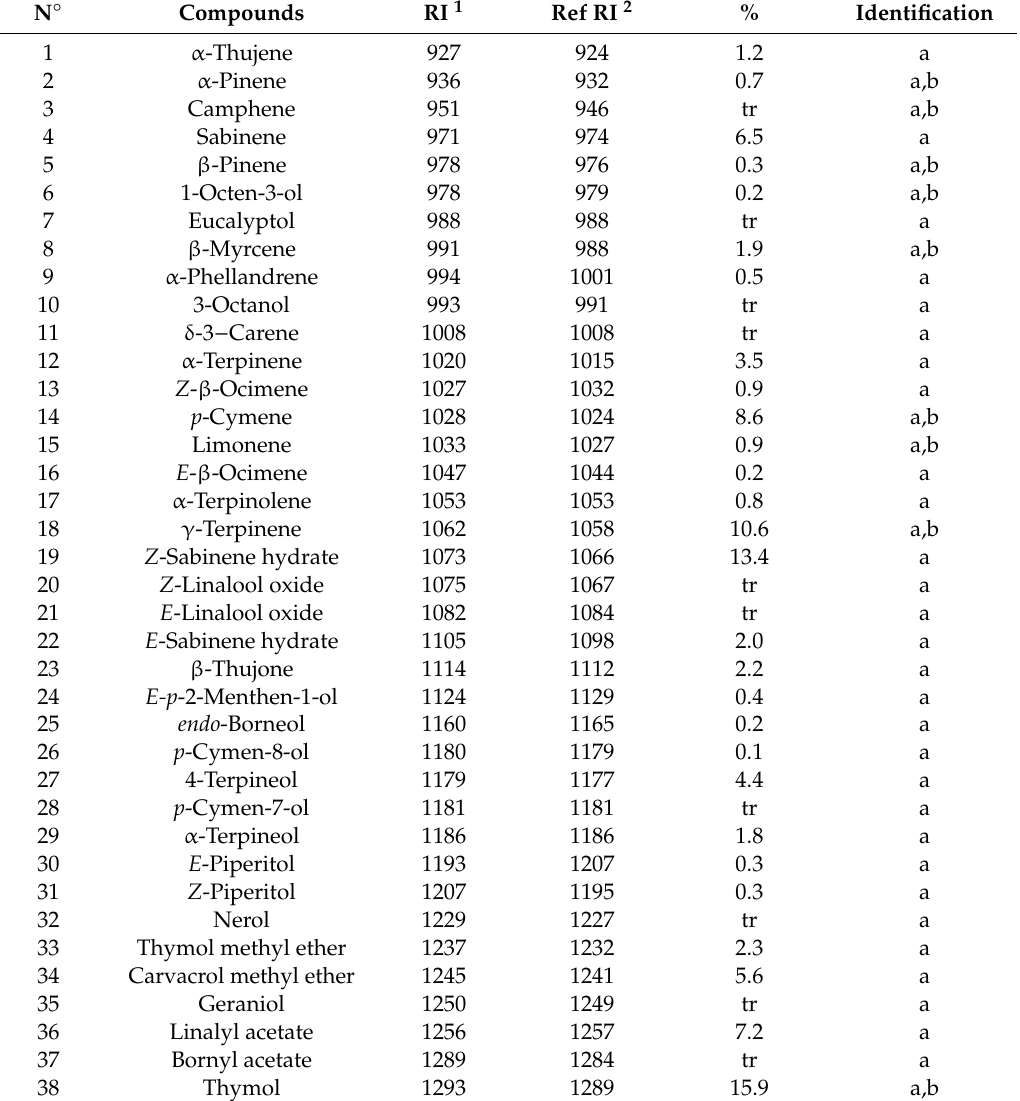
Figure 1. Chemical structures of the main compounds present in the essential oil of O. vulgare from Putre, Chile. Table 2. Chemical composition of volatiles in the Origanum vulgare essential oil from Putre, Chile.